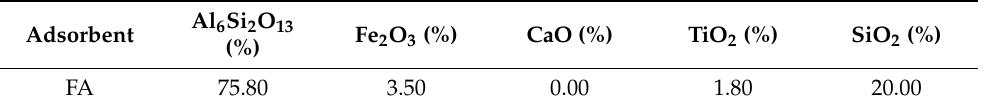
Table 1. XRF analysis of